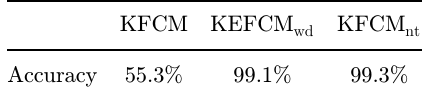
Table 1. Silhouette average values in clustering Yeast dataset.